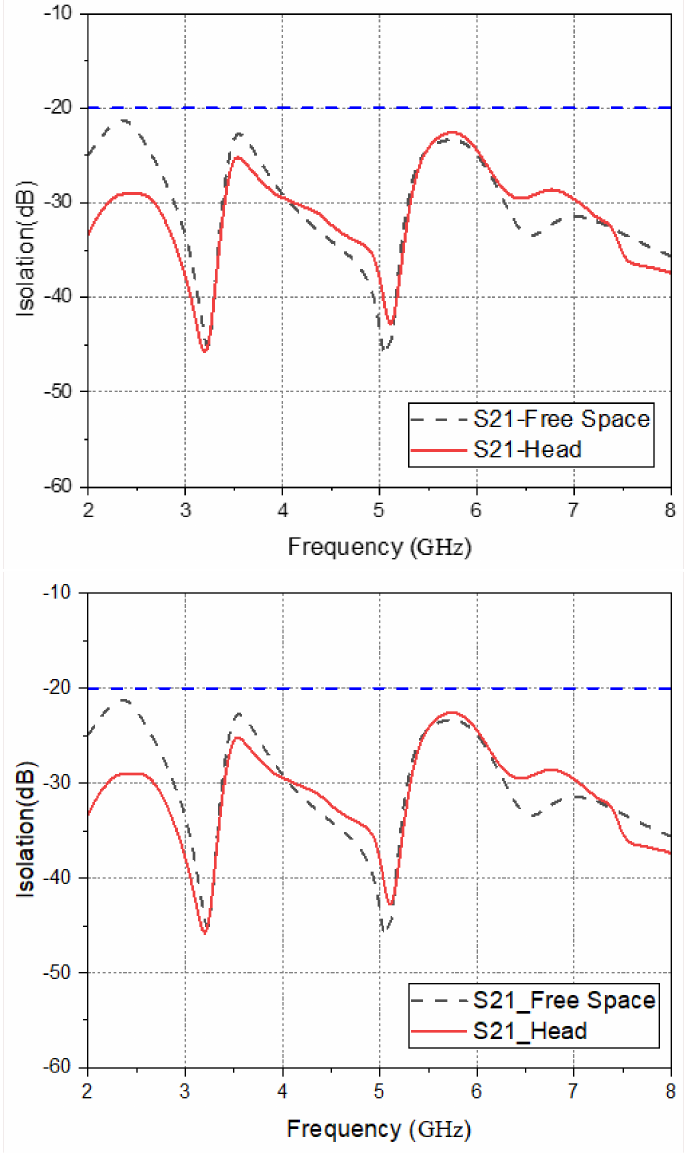
Figure 29. Isolation for simulated Ant. 1 and Ant. 2 in free space and when worn on the head.